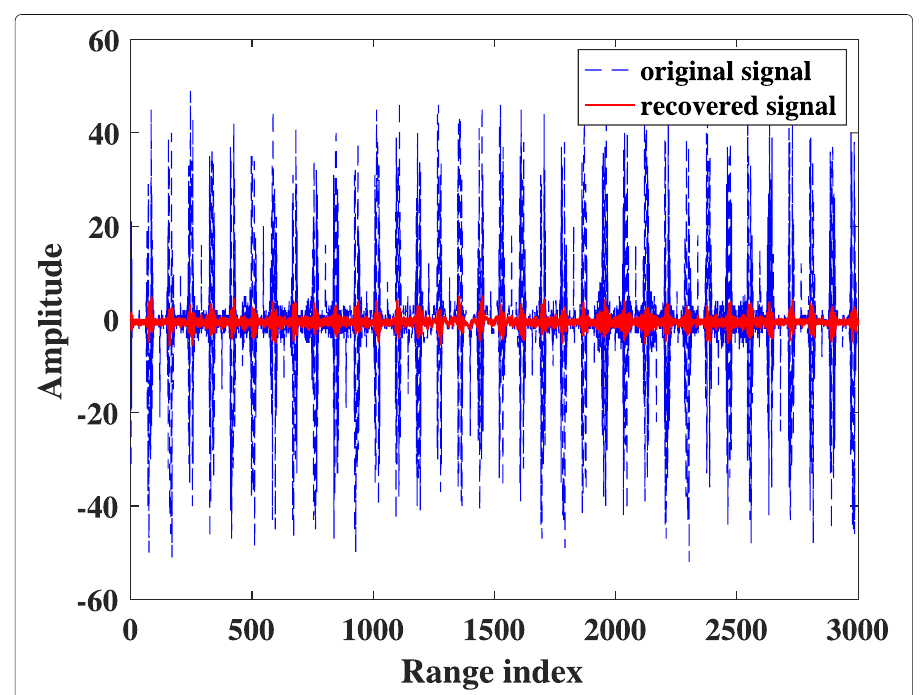
Fig. 9 Real part of the original signal and the recovered